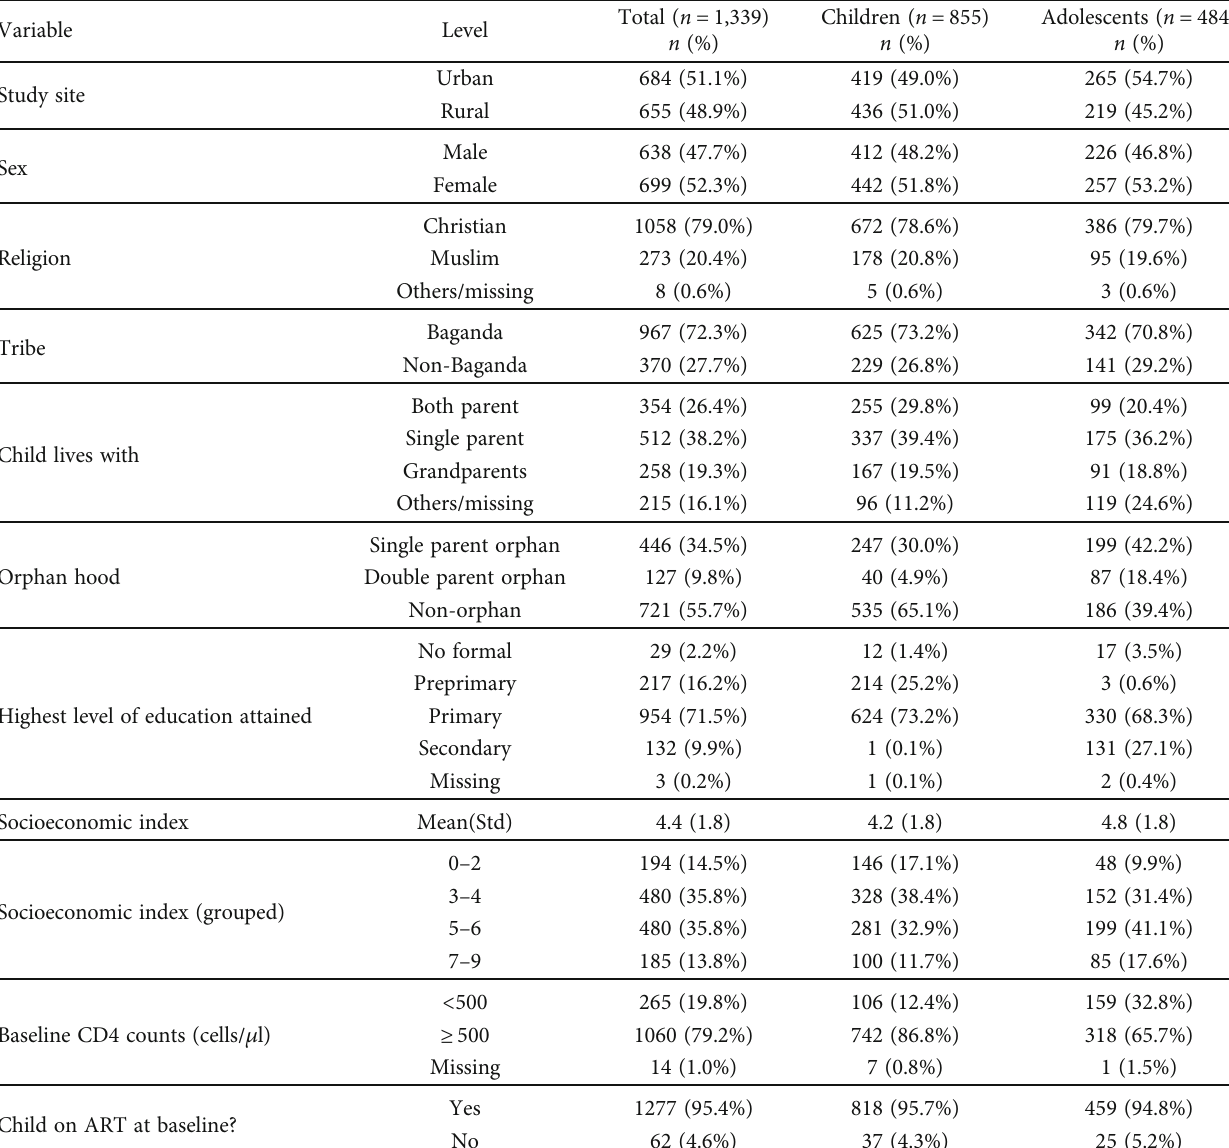
Table 2: Characteristics of study